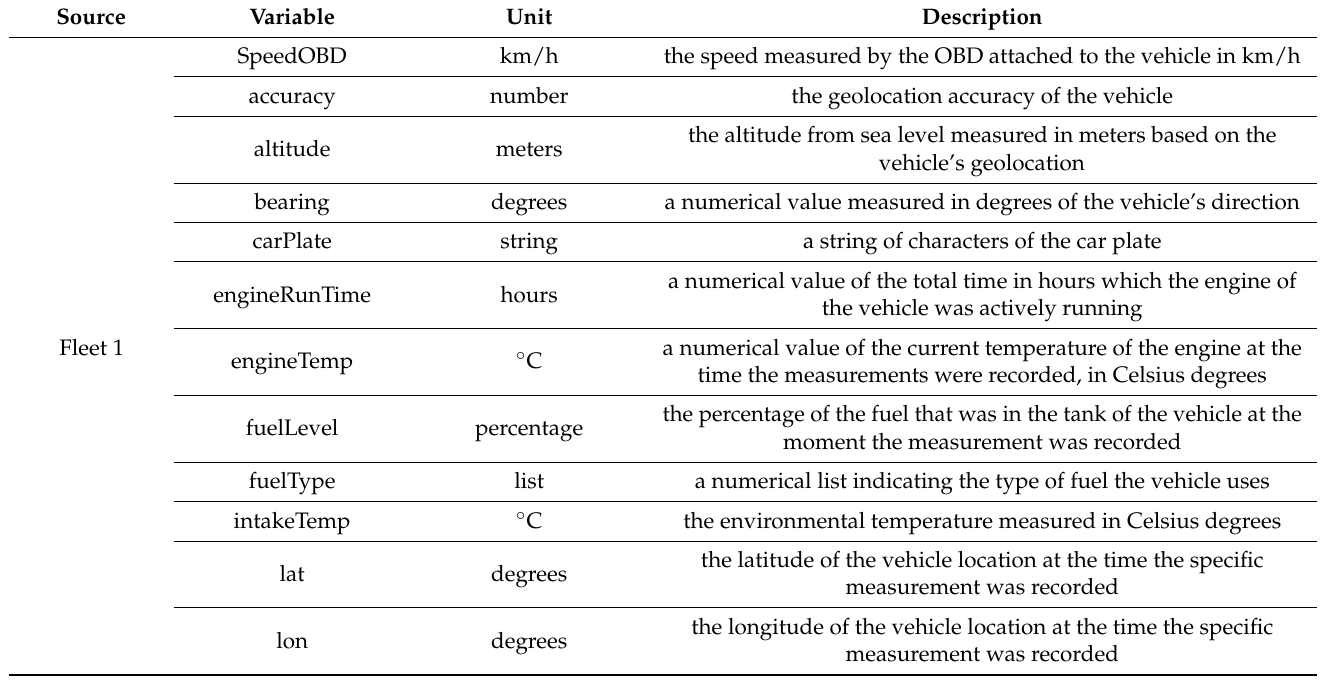
Table 1 features an overview of the data structure of the different data sources. Table 1. The different data formats provided as input to DBDA platform from various sources.